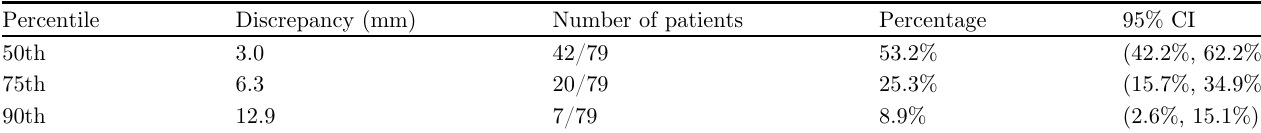
Table 2. Tibial discrepancy percentiles and projected population prevalence. Percentile